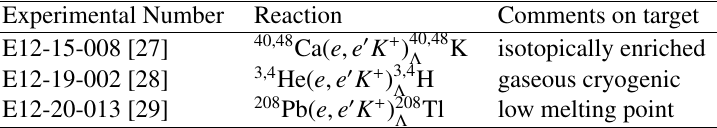
Table 1. Approved JLab experiments on Λ hypernuclear spectroscopy